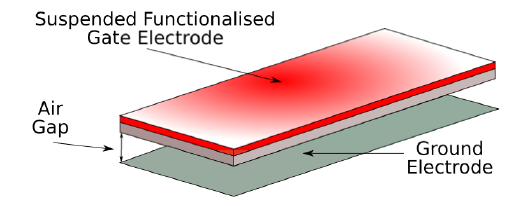
Figure 4. Doubly clamped beam structure used to dynamically analyse the pull-out effects through FEM-based